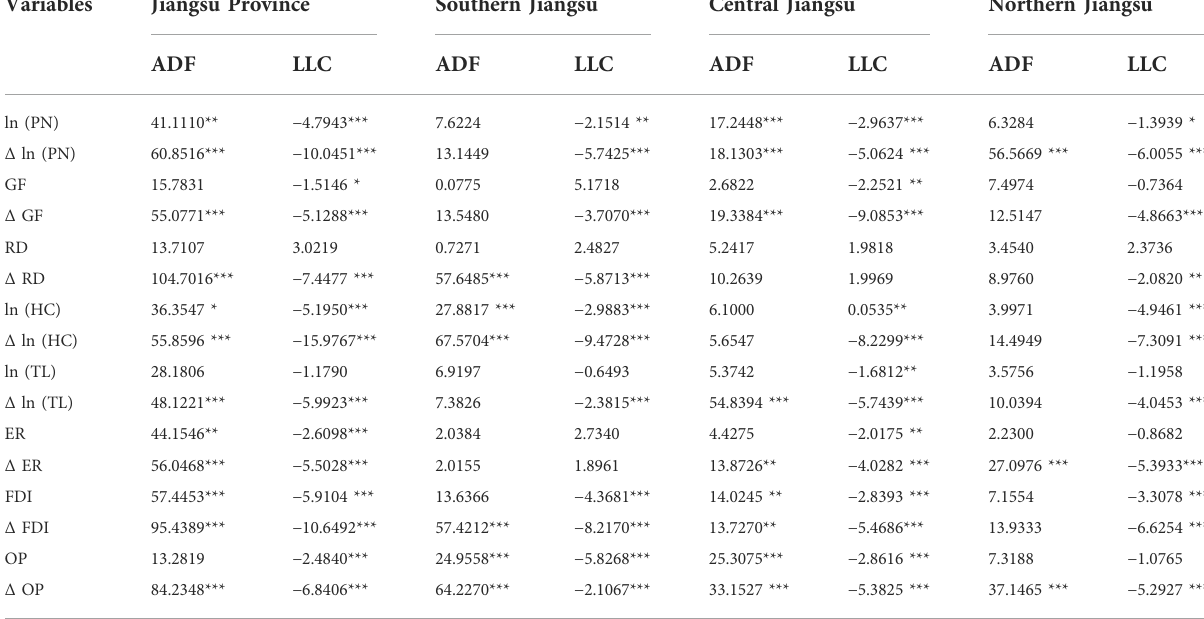
TABLE 3 Unit root test of variables in Jiangsu